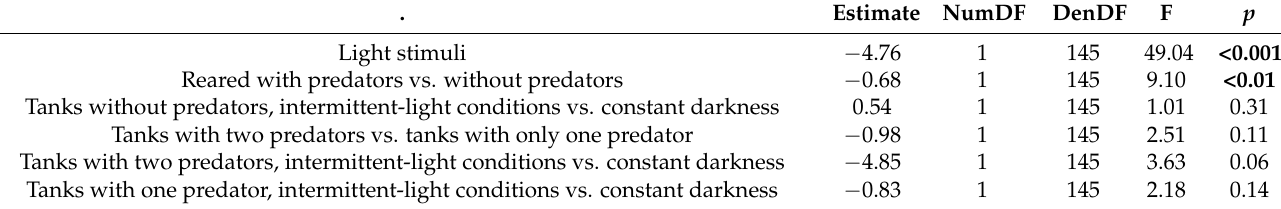
Table 1. Results of the LMM considering the relationship between the behavioral response of the surviving Niphargus thuringius with light stimuli during the test and rearing conditions experienced (statistically significant effects ( p < 0.05)) are highlighted in bold). NumDF = degree of freedom at the numerator; DenDF = degree of freedom at the denominator. . Estimate NumDF DenDF p